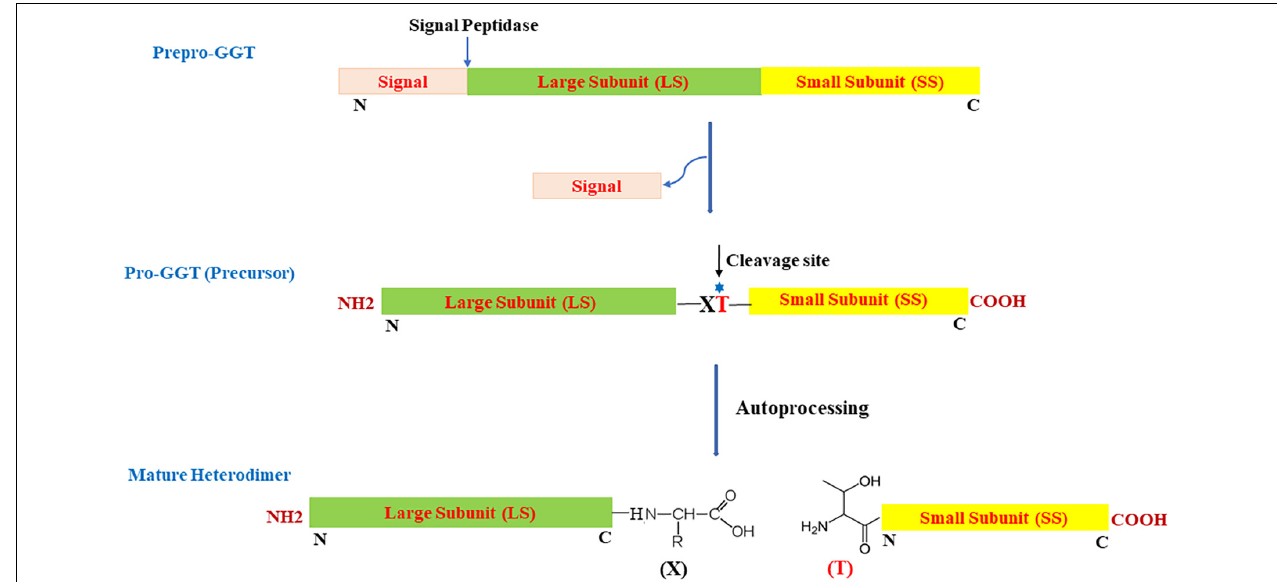
FIGURE 1 | Schematic view of organization and two-step maturation of bacterial gamma-glutamyl transpeptidases (GGTs); the cleavage site represents the site of autoprocessing. T, conserved threonine; X, residue preceding the conserved threonine; N, N-terminus; C,